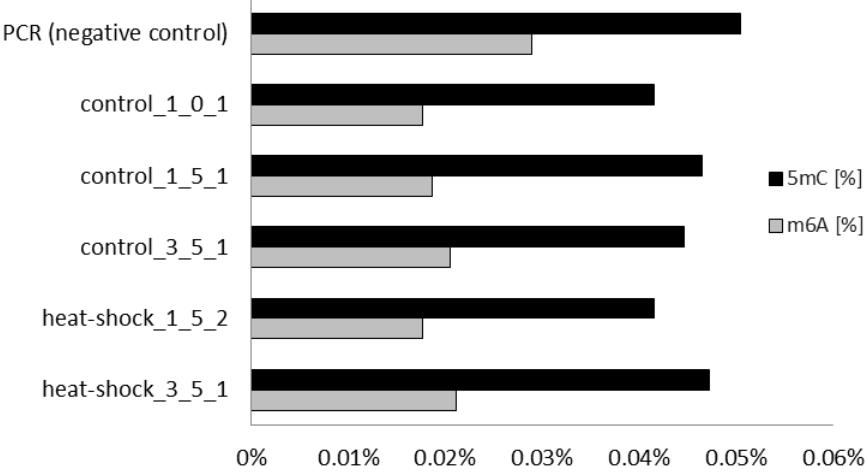
Figure 4. The level of global DNA methylation (5 mC and N6mA) using dam/dcm and CpG model (ONT Guppy basecalling software version 3.6.1). Sample names are encoded: hours after HS/number of HS/number of cycles .